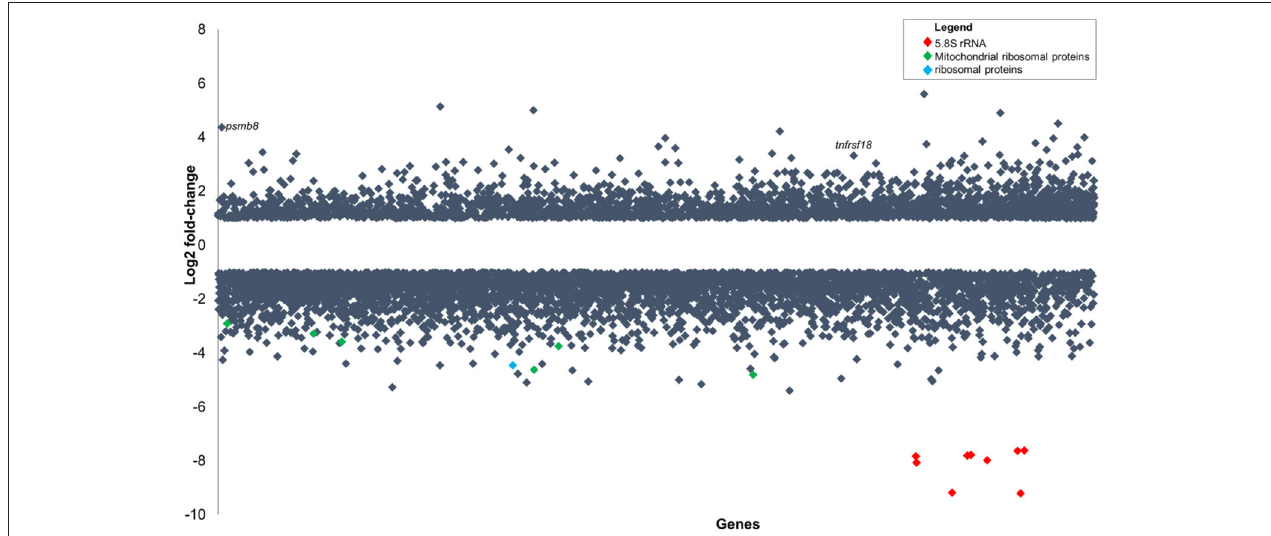
FIGURE 5 | Gene expression changes in zebrafish embryos (log 2 fold-change) infected with P. aeruginosa PASS1 compared to zebrafish embryos injected with phosphate buffered saline. Each dot represents a gene within the zebrafish genome (x-axis) and its fold-change (log 2 ) expression 3 dpi ( p ≤ 0.01 and log 2 fold-changes cut-off − 1 ≥ to ≤